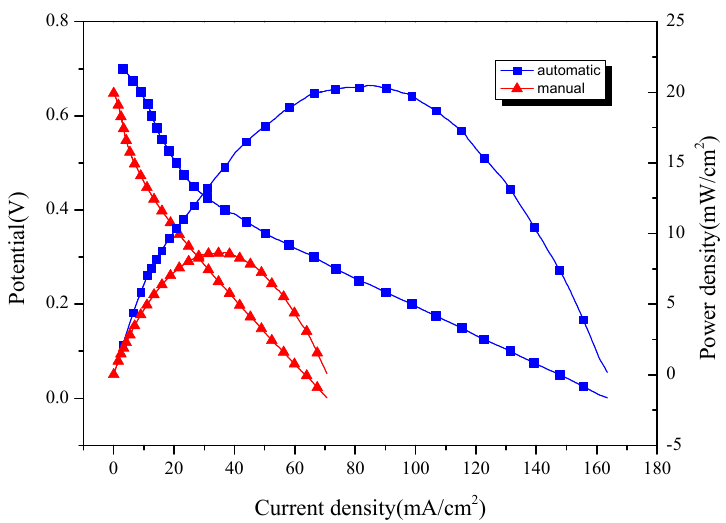
Figure 15. Power density curves of single cells obtained by different coating methods.